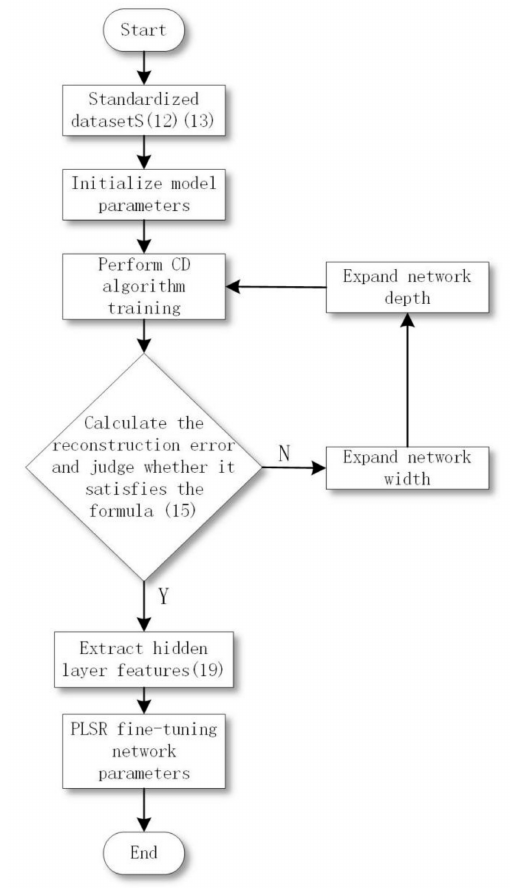
Figure 4. DBN structure construction